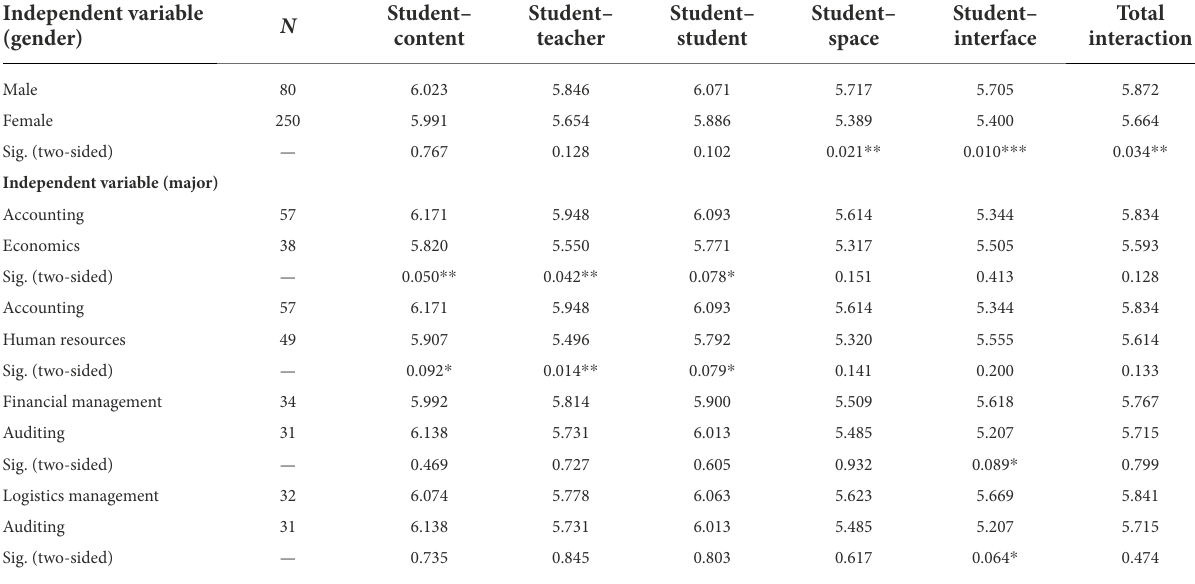
TABLE 4 Relationship between sample characteristics and interaction preference. Independent variable